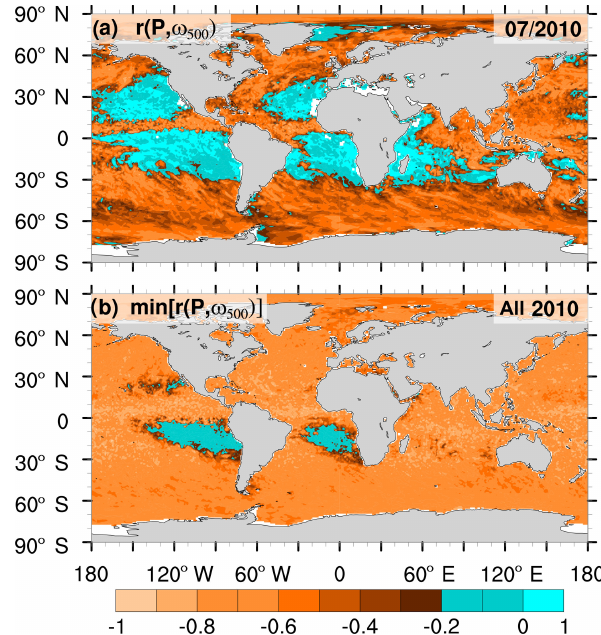
Figure 3. Maps of temporal correlation r(P,ω 500 ) for each ERA5 grid box for (a) July 2010 and (b) the minimum monthly correla- tion for the year 2010. Blue colored areas are weakly or positively correlated and are excluded from further analysis ( r > − 0 . 2; Emori and Brown, 2005).